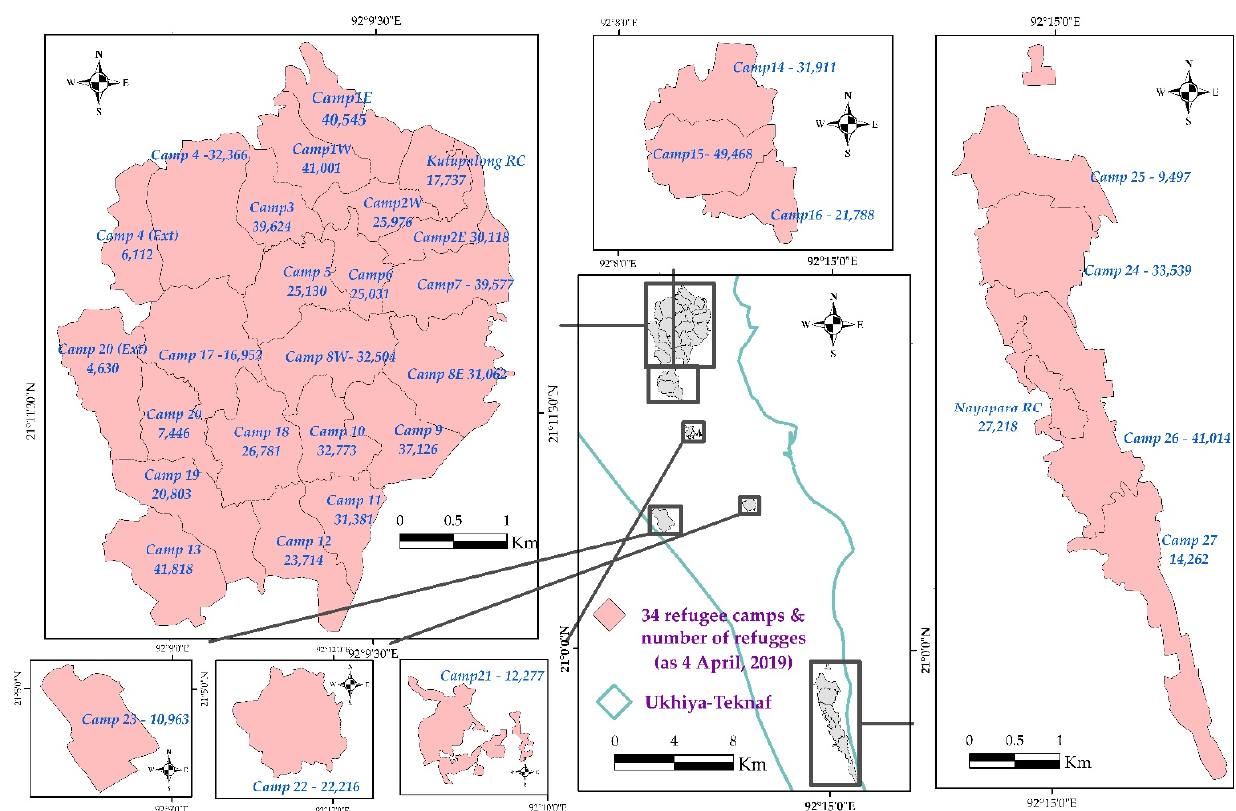
Figure 3. Location and representational map of all the thirty-four Rohingya refugee camps and the number of refugees in each camp, as of 4 April 2019 (data source: https://www.unhcr.org/ (accessed on 20 April 2019)).